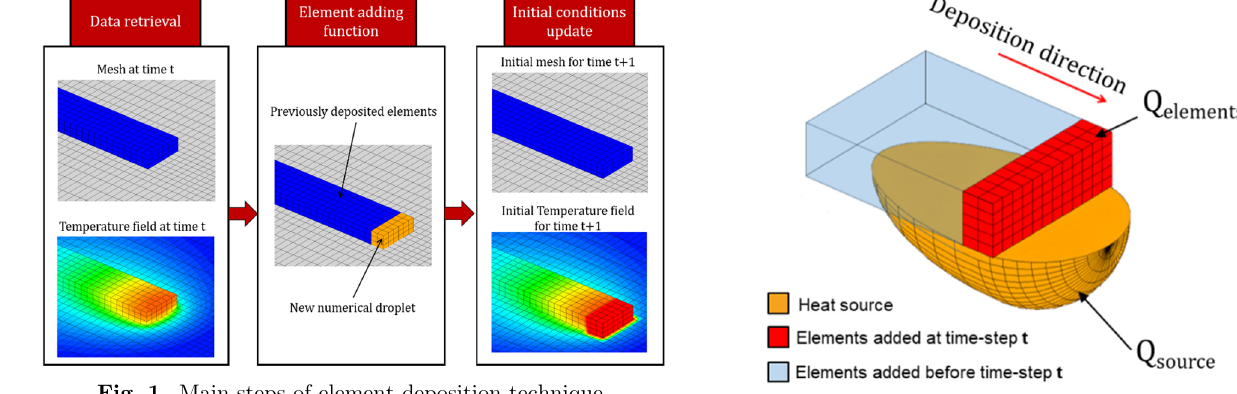
Fig. 3. Adapted Goldak